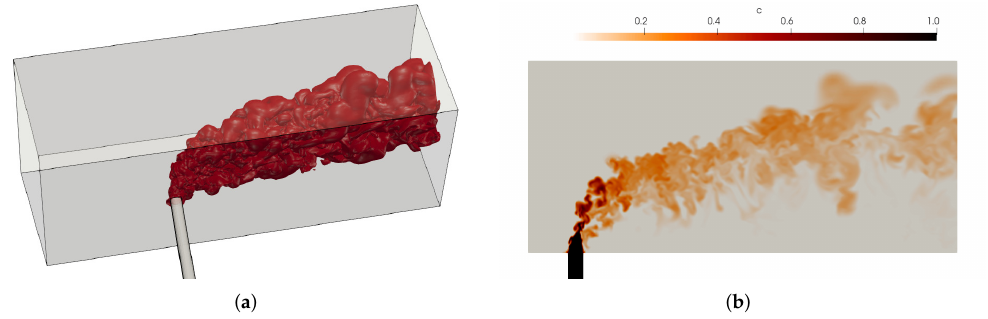
Figure 12. Results obtained using the WALE model with AMR: ( a ) isosurface of the passive scalar c = 0.01; ( b ) distribution of scalar c at y / D =